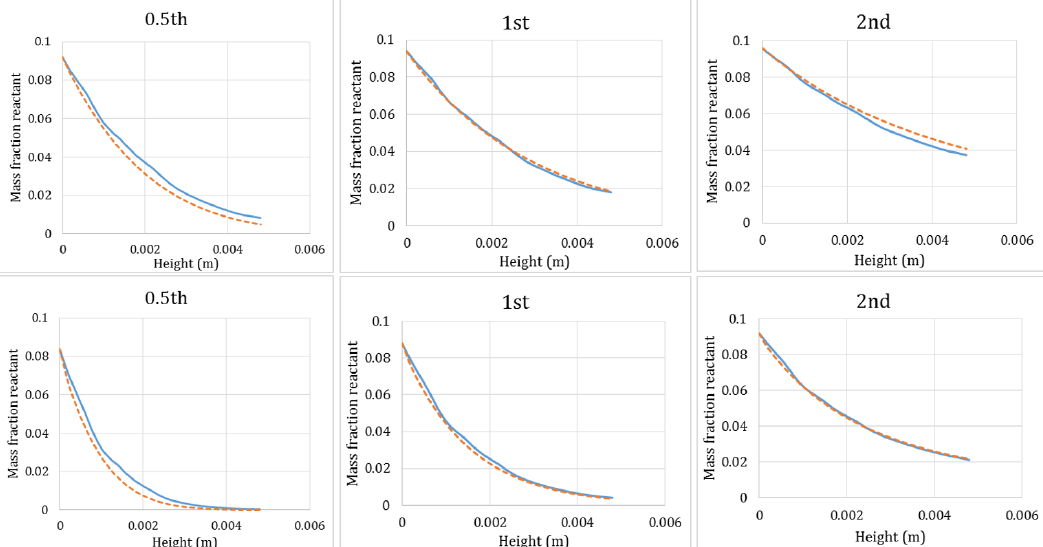
Figure 5. Comparison of the mass fraction of reactant (x A ) between the two approaches (i) PR-DNS (represented by solid lines); (ii) 1D model (dashed lines) for [Top] Thiele modulus 𝜙 = 10), and [Bottom] 𝜙 = 5 for different reaction orders (0.5th, 1st, 2nd); along the height of the reactor geometry.